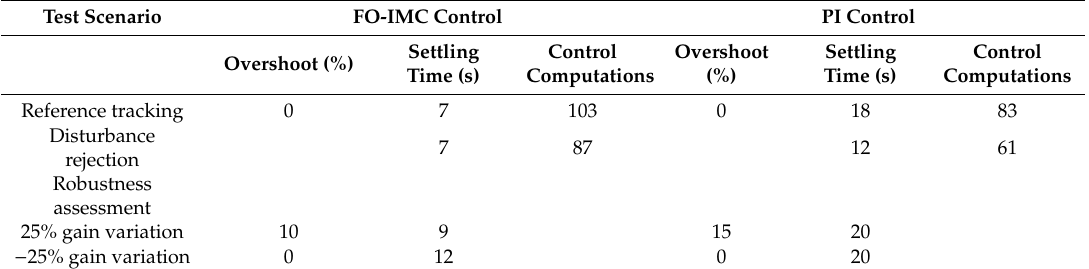
Table 2. Performance comparison between the event-based FO-IMC and event-based PI controller for the delay dominant FOPDT